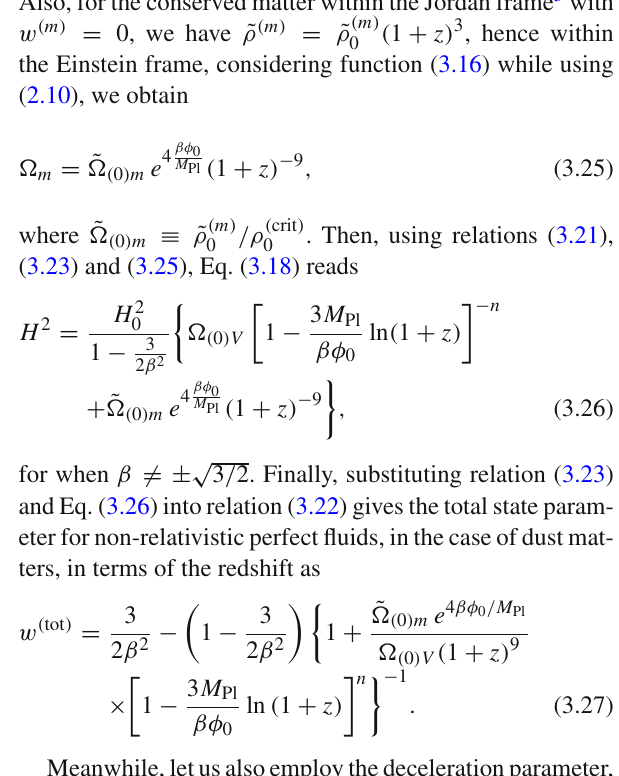
is an upper bound on this parameter in the chameleon model that is consistent with the experimental constrain obtained in Ref.